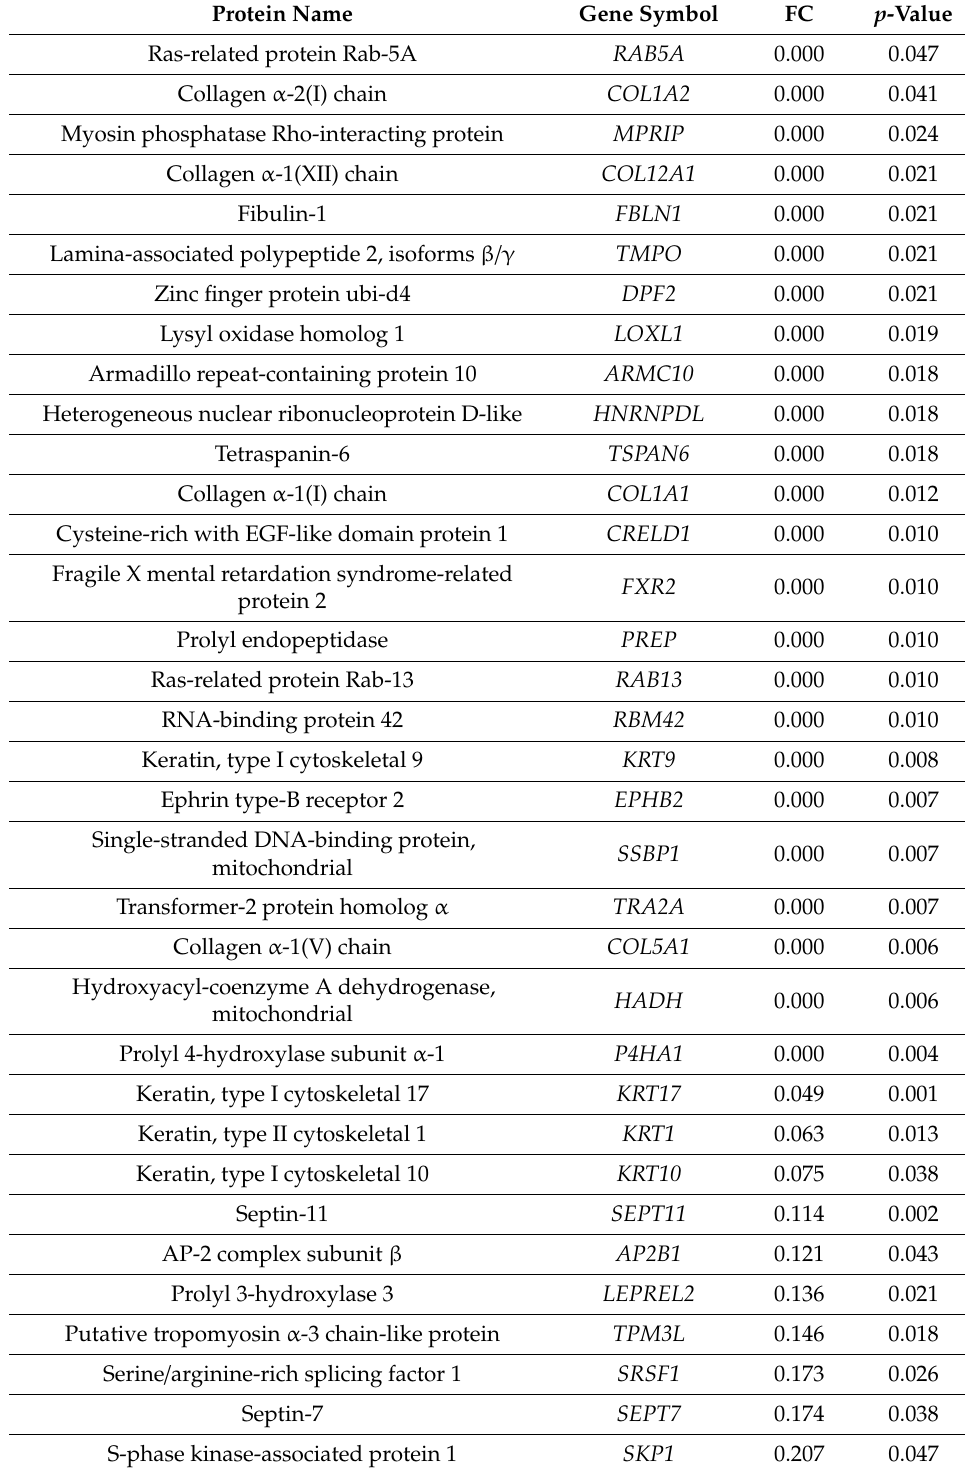
Table 2. Significantly downregulated proteins in human fetal retinal pigment epithelial cells (RPE) cultured in Dulbecco’s Modified Eagle’s Medium (DMEM) with 1% sericin compared to cells cultured in DMEM without sericin. Fold change (FC) was calculated as follows: FC = ((mean of protein expressions in RPE cultured in DMEM with 1% sericin) / (mean of protein expressions in RPE cultured in DMEM without sericin)). N = 3. FC: Fold